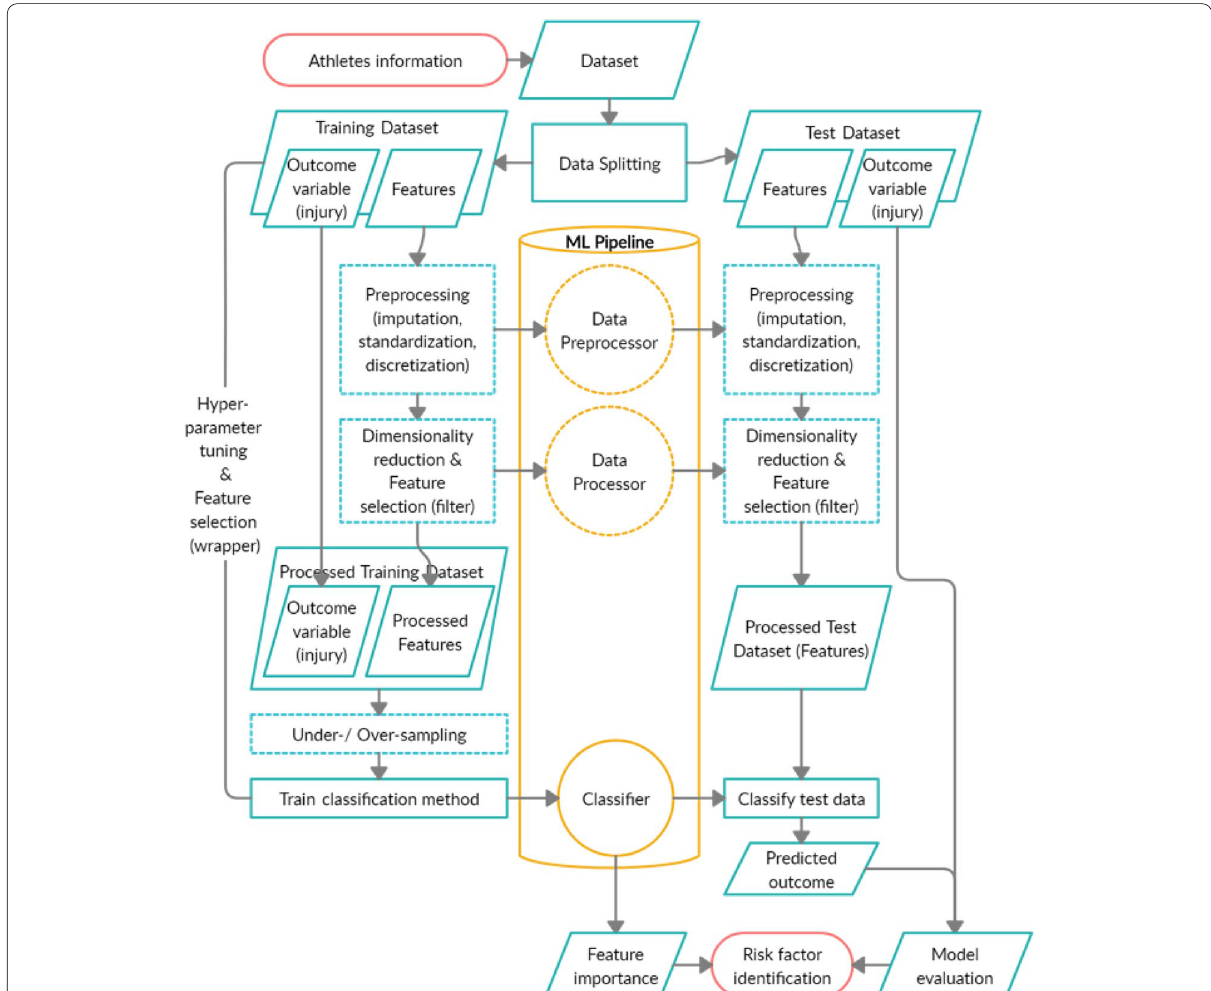
Fig. 1 Schematic figure of the Machine Learning approach. The entire Machine Learning process is shown. Parts in dotted shapes are optional or not always